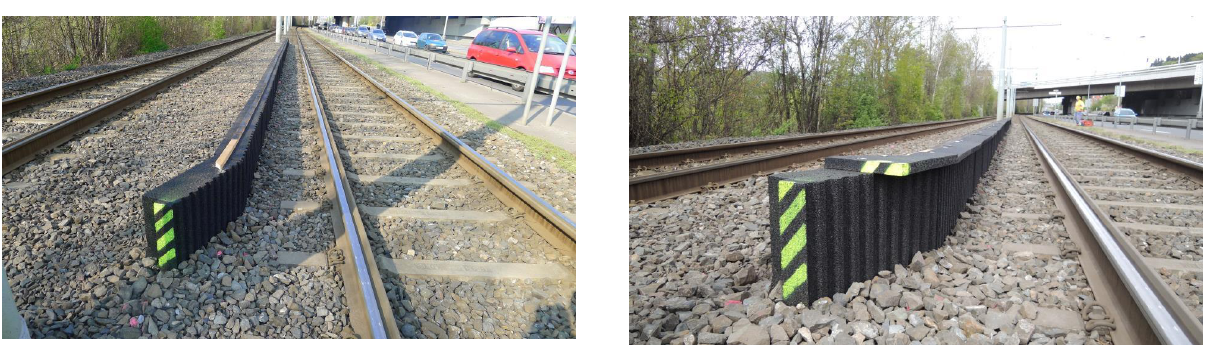
70 mm in length, at the screen face to further reduce the arising noise. Thanks to the board overlap, the screen face was shifted towards the track, from the original distance of 1.42 m from the rail axis to 1.35 m after the modification. The modification is evident from Figure 9.